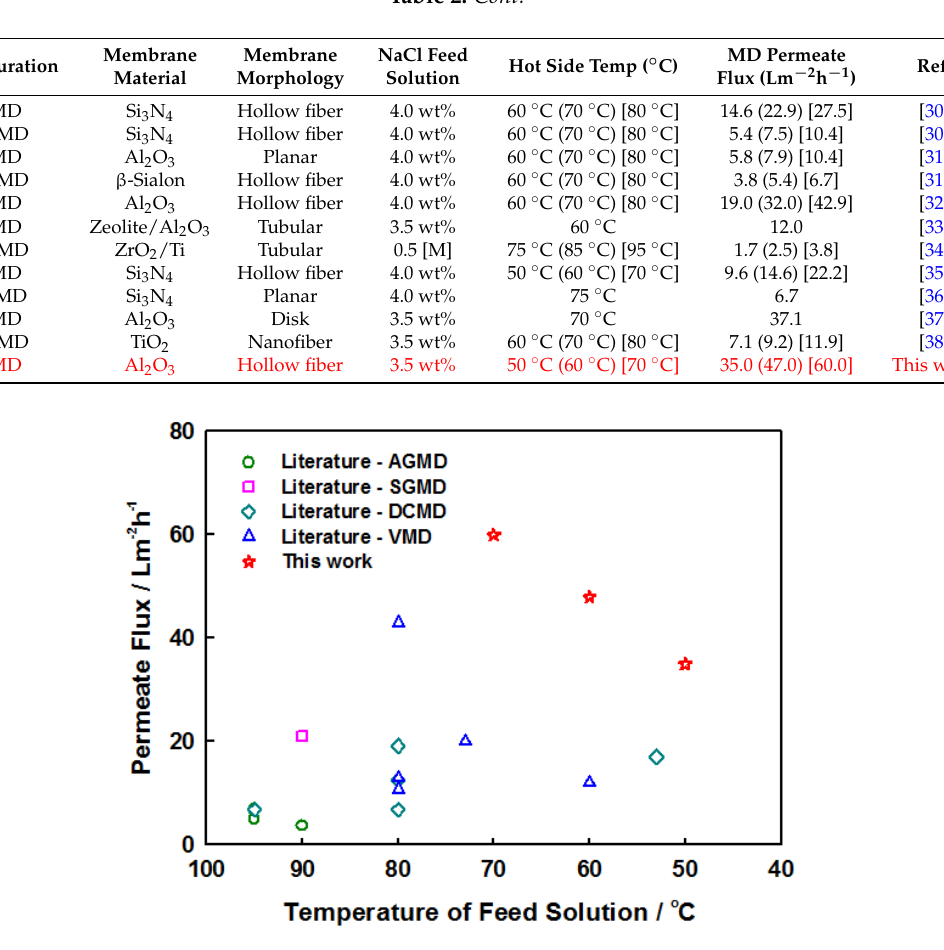
Figure 7. A comparison between the MD permeate flux value obtained from this work and historical data, as a function of feed solution temperature.